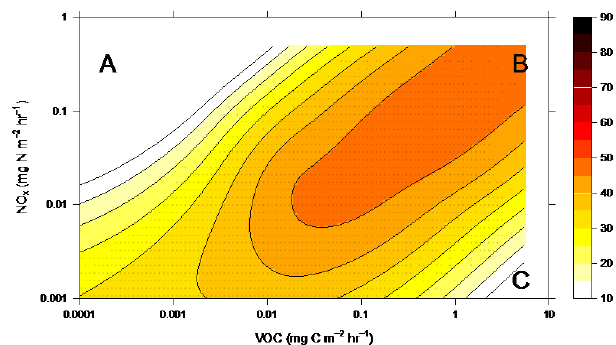
Figure 4. O 3 mixing ratios (ppb) as a function of VOC and NO x emissions as computed using the UKCA model of atmospheric chemistry (Archibald et al., 2011). Three main regions are identi- fied. Top left corner (A): region of NO x saturation and O 3 titration. Bottom right corner (C): region of VOC saturation and O 3 destruc- tion. Diagonal elements (A–C, B–C): efficient conversion of NO– NO 2 and hence O 3 production increasing with increasing VOC and NO x emissions (NB: log 10 scales for